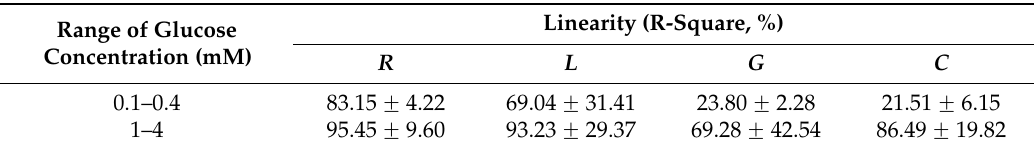
Table 1. R-square of resistance ( R ), resonance feature of inductance ( L ), shunt conductance ( G ), and shunt capacitance ( C ).